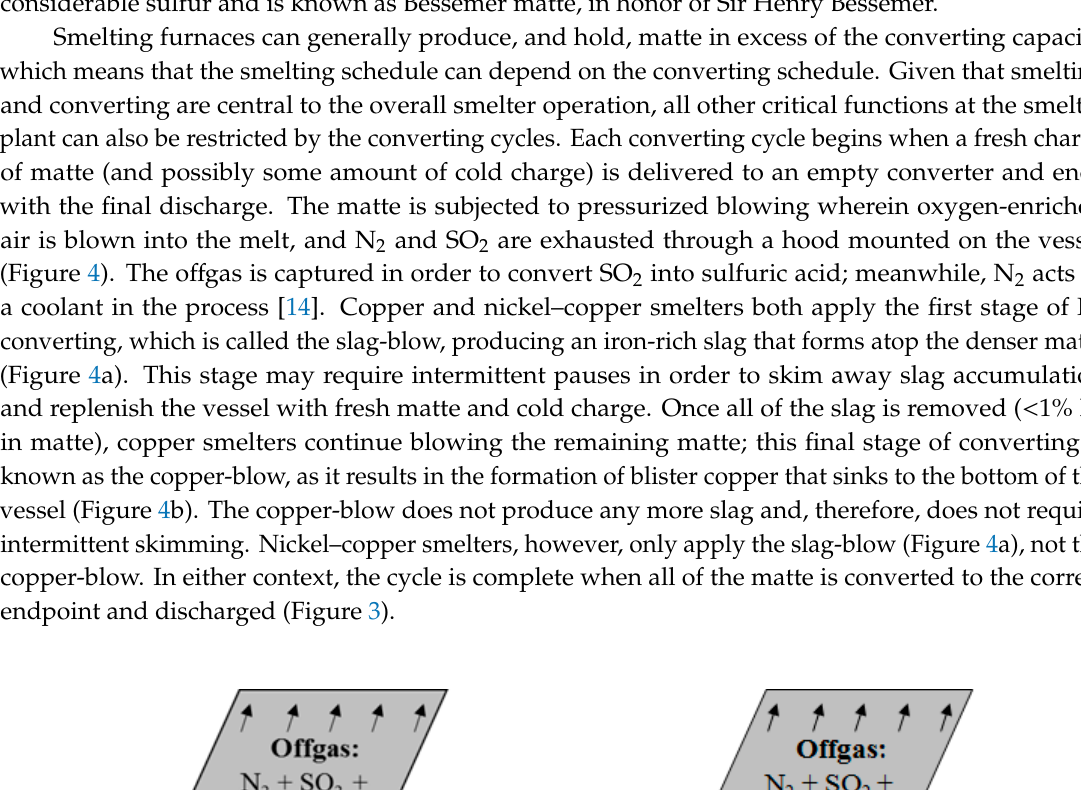
Figure 3. Schematic of conventional copper or nickel – copper sulfide smelter operations. The smelting